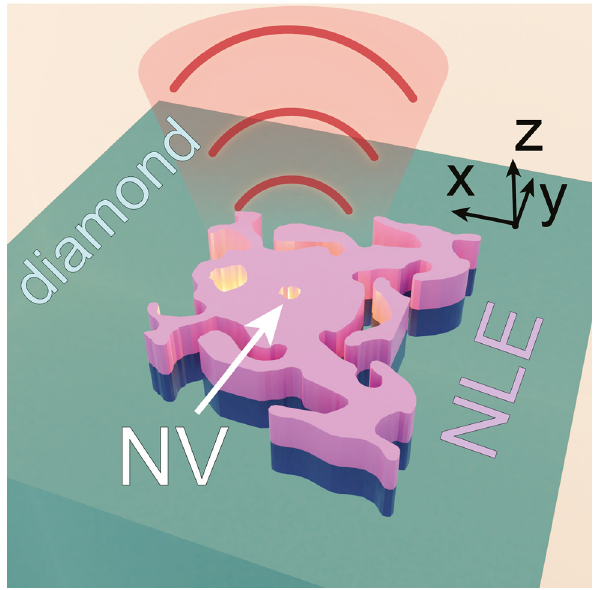
Figure 1: Schematic of the nanoscale light extractor (NLE), which sits on the diamond surface above a nitrogen-vacancy (NV) center and directs fluorescence out of the diamond and into a narrow cone in the far field.